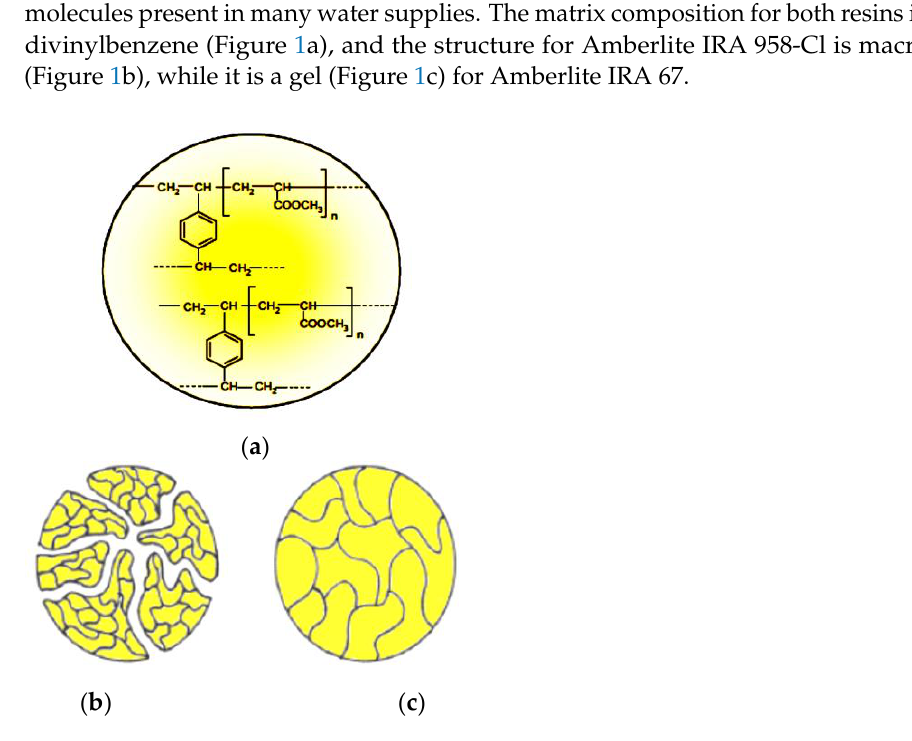
Figure 1. Composition of resin matrices: ( a ) acrylic-divinylbenzene skeleton, ( b ) macroporous, ( c ) gel [43]. The resins were washed with distilled water to remove impurities and